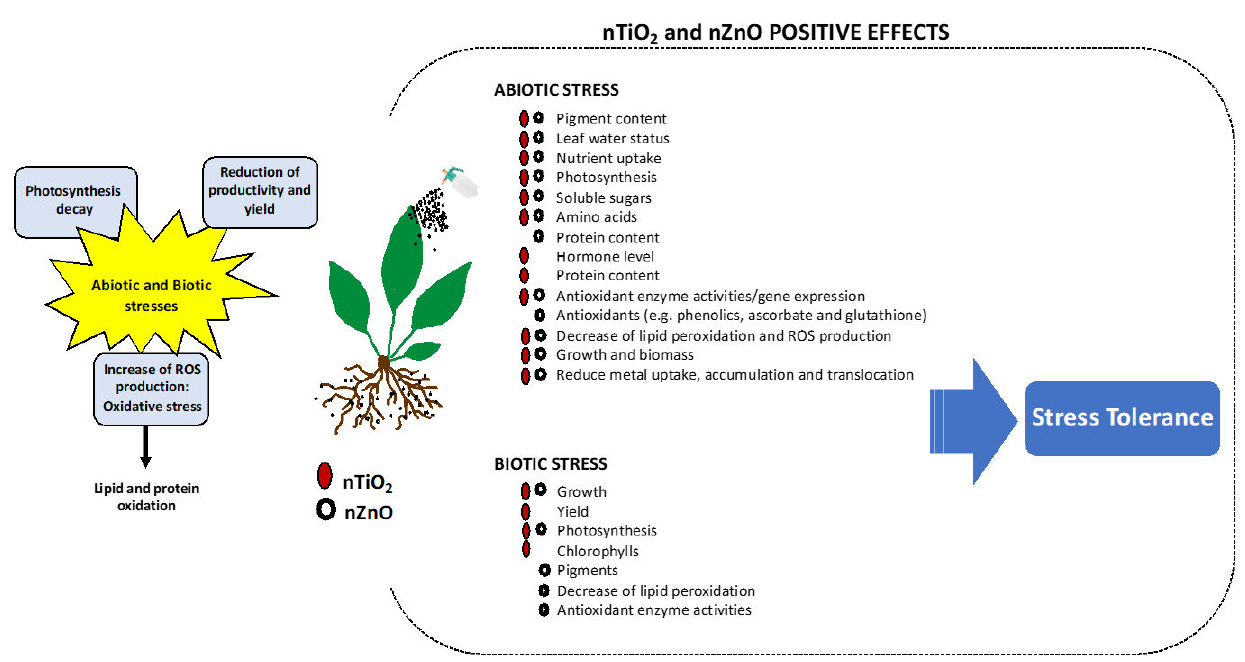
Figure 1. Representative scheme illustrating the positive effects of nZnO and nTiO 2 application on plant physiology reported for plants grown under abiotic and biotic